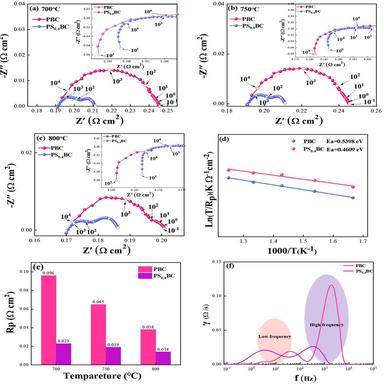
(a–c) The electrochemical impedance spectra of the Pr1-xSrxBaCo2O5+δ cathode materials in the temperature range of 700–800 ◦C; (d)The Arrhenius plot of PBC and PS0.4BC cathode materials; (e)Rp values of PBC and PS0.4BC cathode at each temperature point; (f) Resultant DRT of Pr1-xSrxBaCo2O5+δ symmetric cell measured at 800 ◦C in air atmosphere.